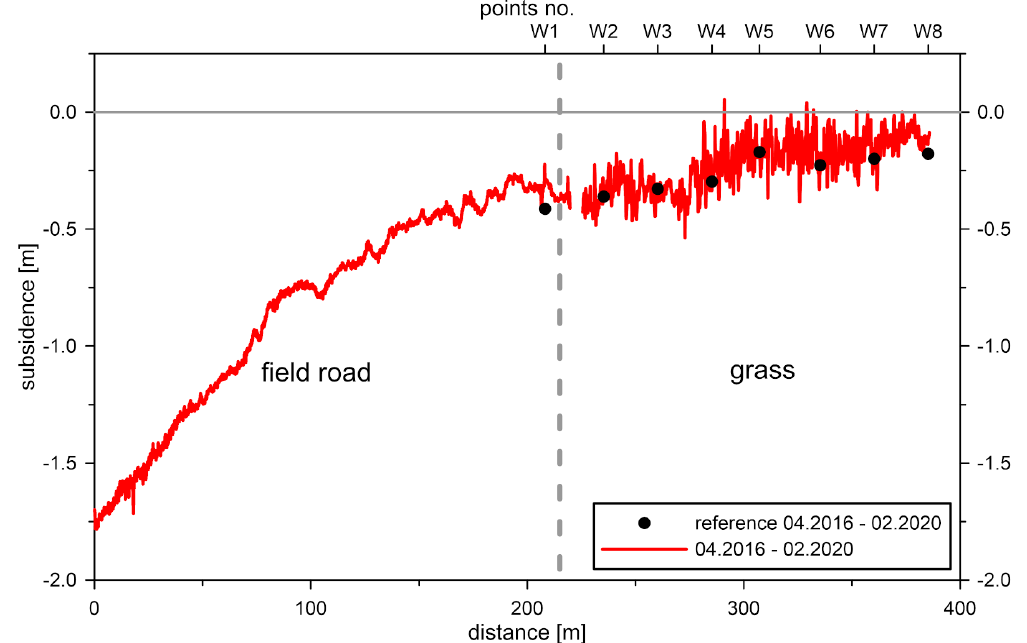
Figure 6. A profile of Jaworzno site subsidence along the W profile (marked by blue line in Figure 2) based on UAV photogrammetric data is compared to reference measurements.